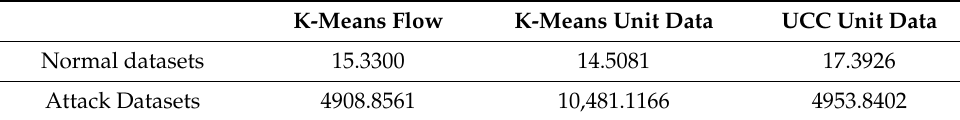
Table 5. Pre-processing time of k-means A-NIDS and UCC A-NIDS (in seconds).